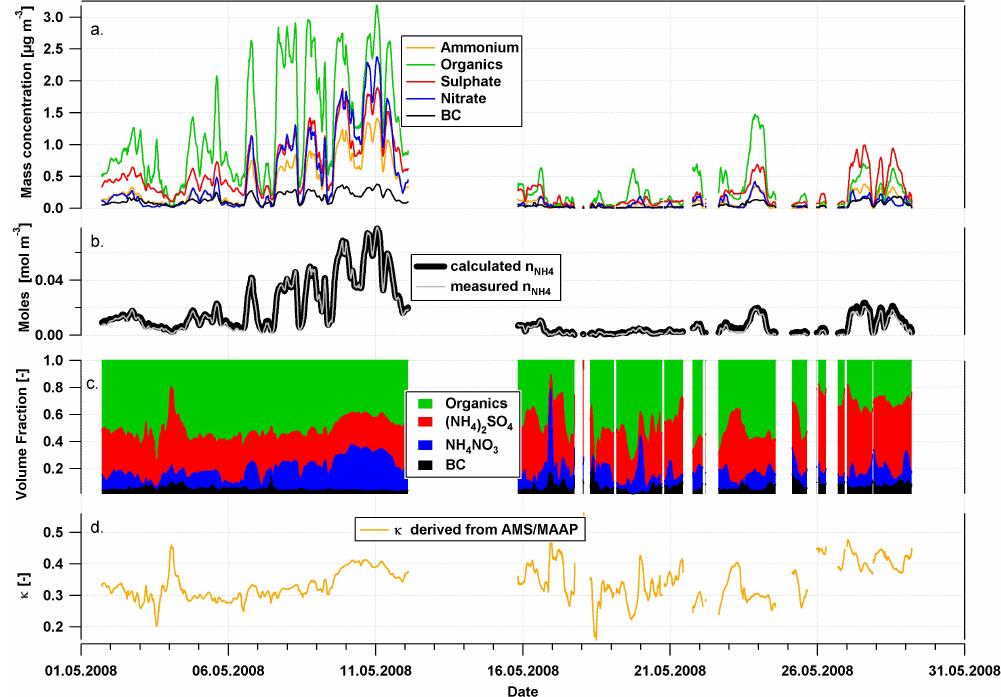
Fig. 3. Chemical composition of the aerosol, measured by the AMS and the MAAP. (a) shows the mass concentration of the individual species using a collection efficiency of 1 in the AMS. (b) shows the molar concentration of the measured NH 4 and the amount that is needed for complete neutralization. On (c) the volume fractions of the organics, NH 4 NO 3 , ( NH 4 ) 2 SO 4 and black carbon are shown; the calculation was done using the density values of 1270kg / m 3 , 1720kg / m 3 , 1769kg / m 3 and 1770kg / m 3 , respectively. (d) shows the hygroscopicity parameter κ which was calculated from the volume fraction weighted sum of the κ i values of the above